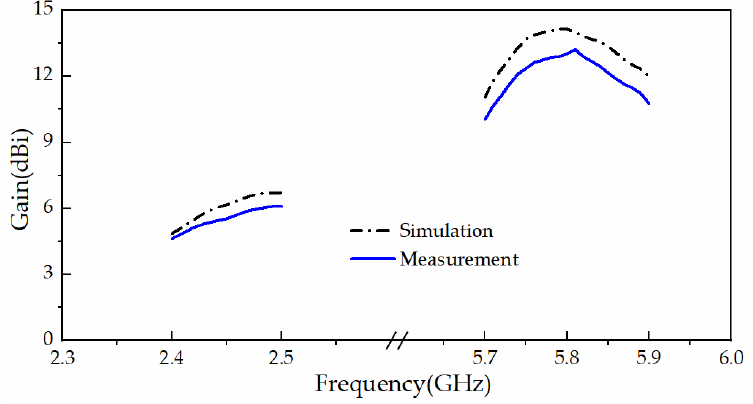
Figure 9. Simulated and measured gain of the proposed DRA array.